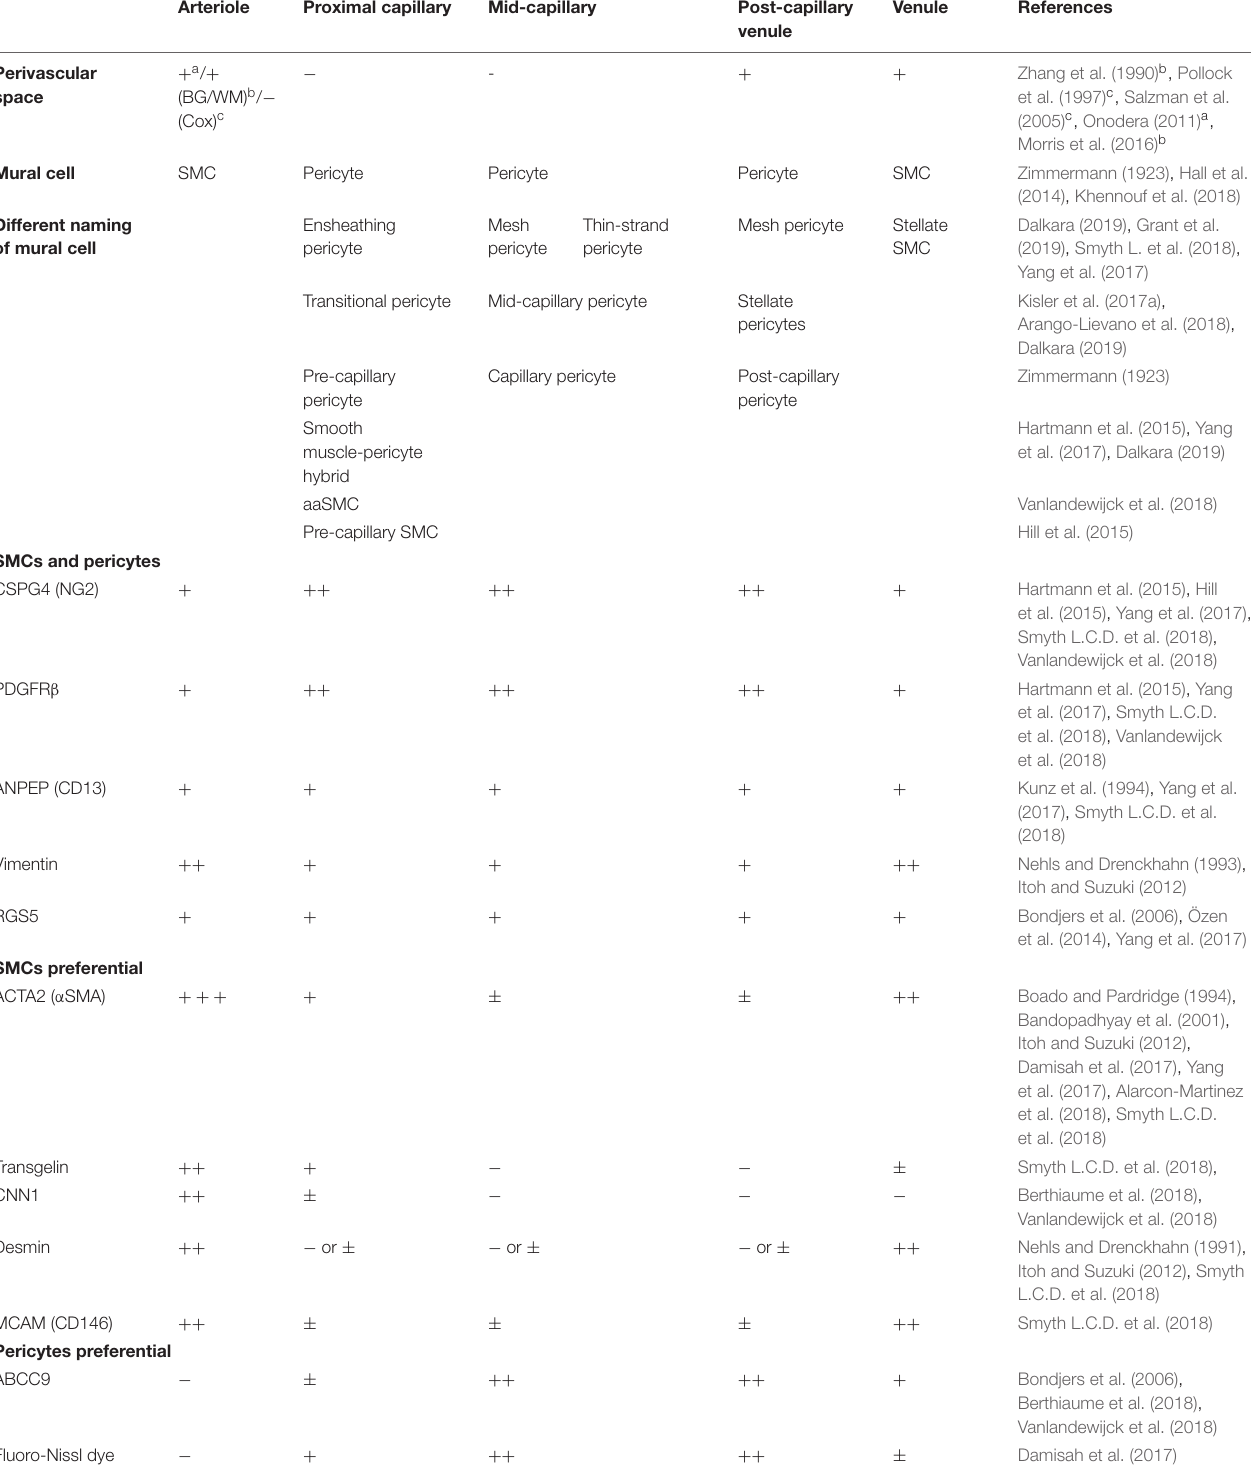
TABLE 1 | Anatomical differences in brain small vessels and mural cell